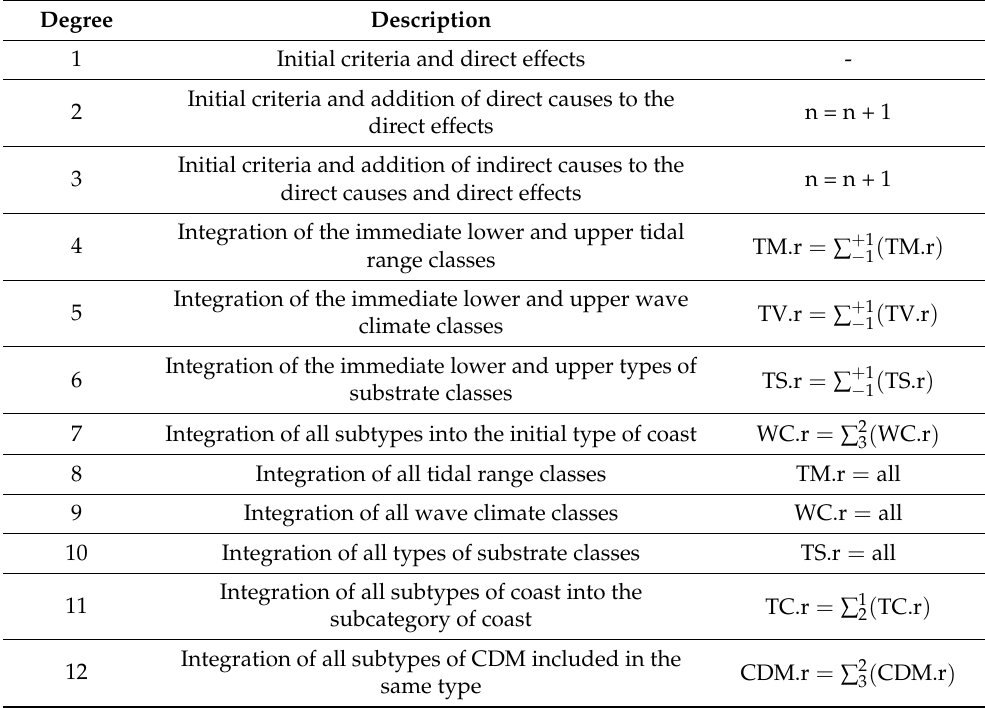
Table 9. Degrees of enlargement of user-selected environmental